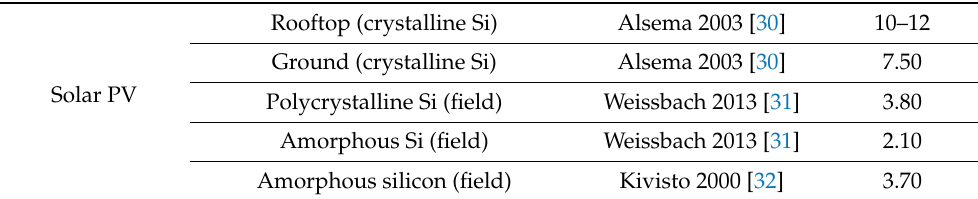
Table 5. Values of EROI for the PV industry. Adapted from